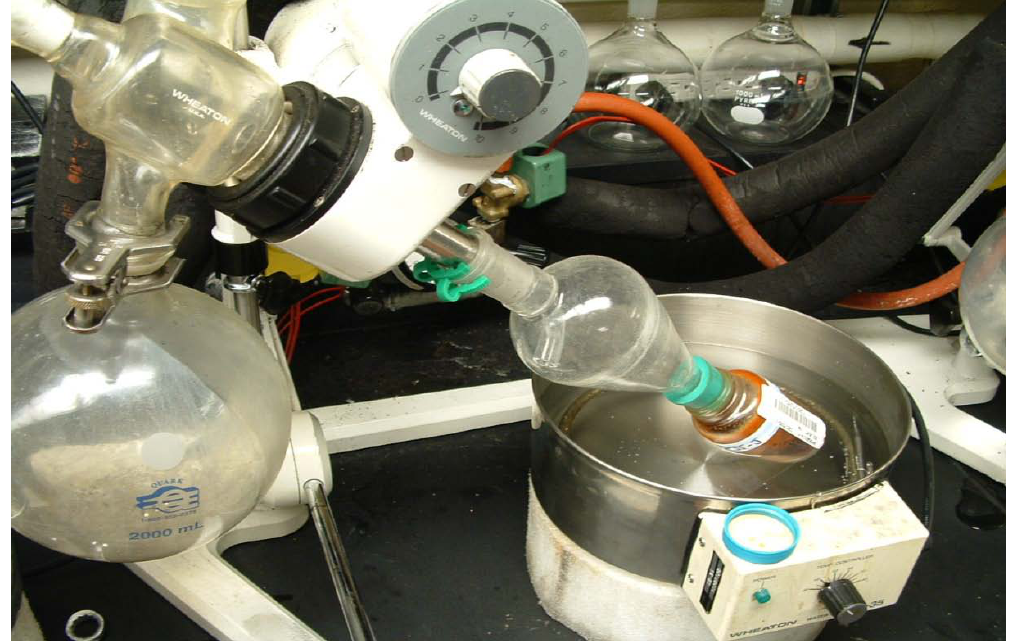
Figure 8. Rotary evaporating to concentrate extract into a bulk storage bottle. Note design of bump trap, Keck clip, Neogreen stopper, vacuum-rated solenoid tied to rotovap rheostat and multiple labeling of the